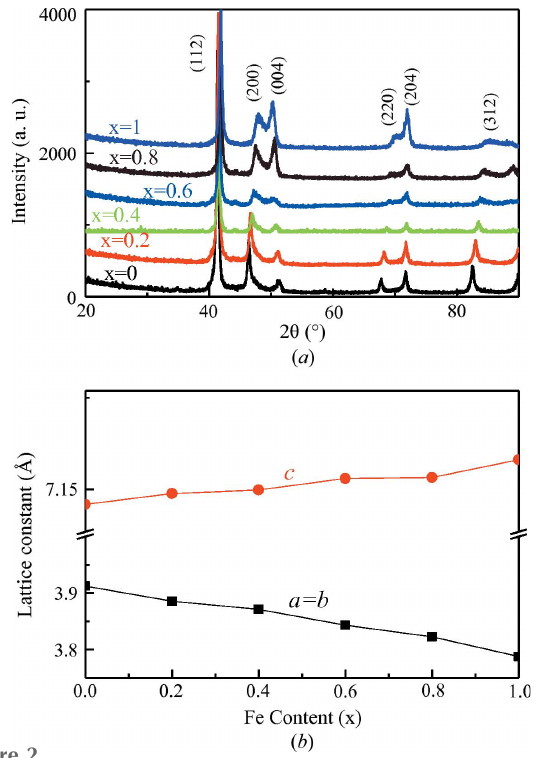
Figure 3 ( a ) XRD spectra measured at room temperature for Mn 3 (cid:2) x Fe x Ga samples heat treated at 883 K; ( b ) effects of Fe substitution with Mn on the lattice parameters.